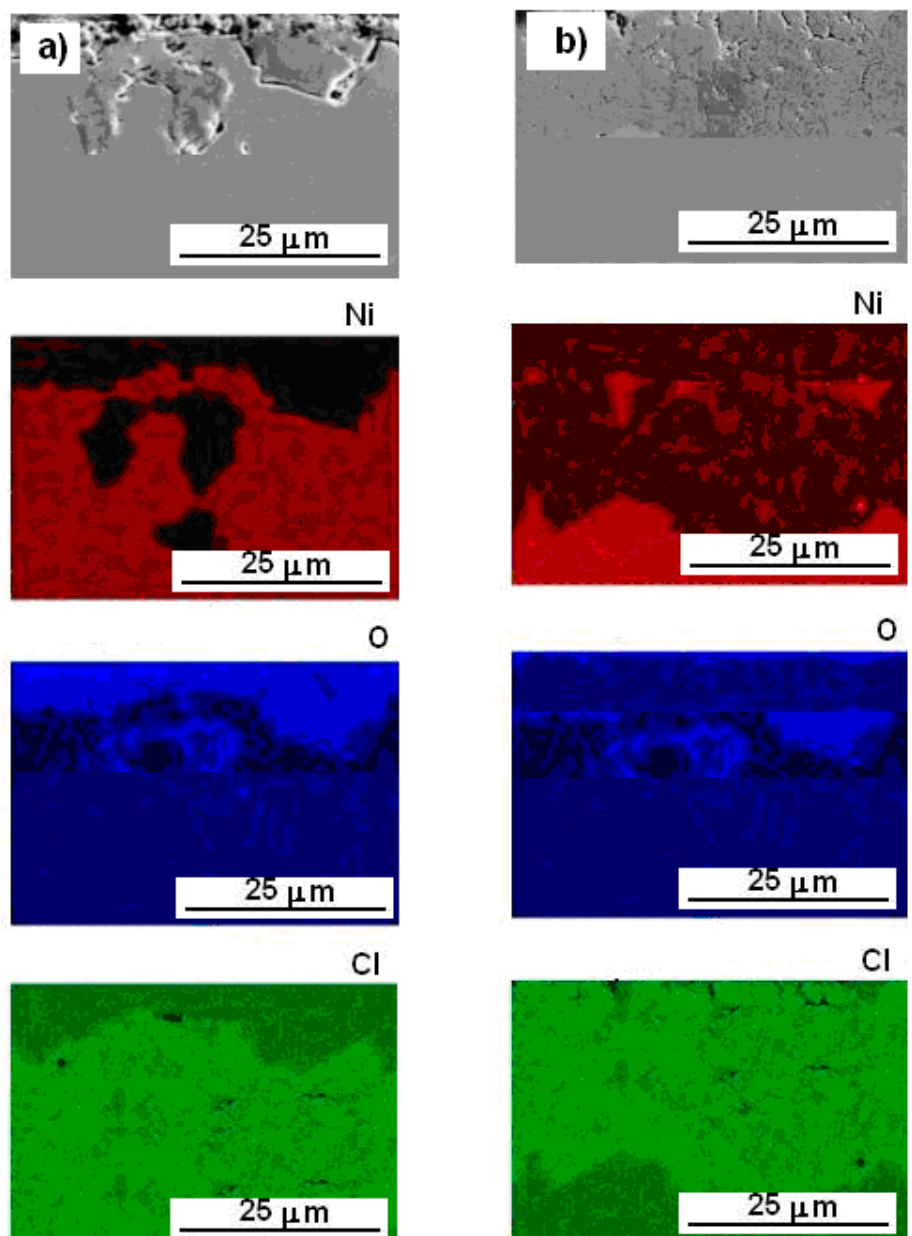
Figure 11. Cross-sectional SEM micrograph and EDS elemental maps for: ( a ) M28 and ( b ) O60 nickel coatings after the corrosion test in 1.2 M Cl − , pH 1.5.